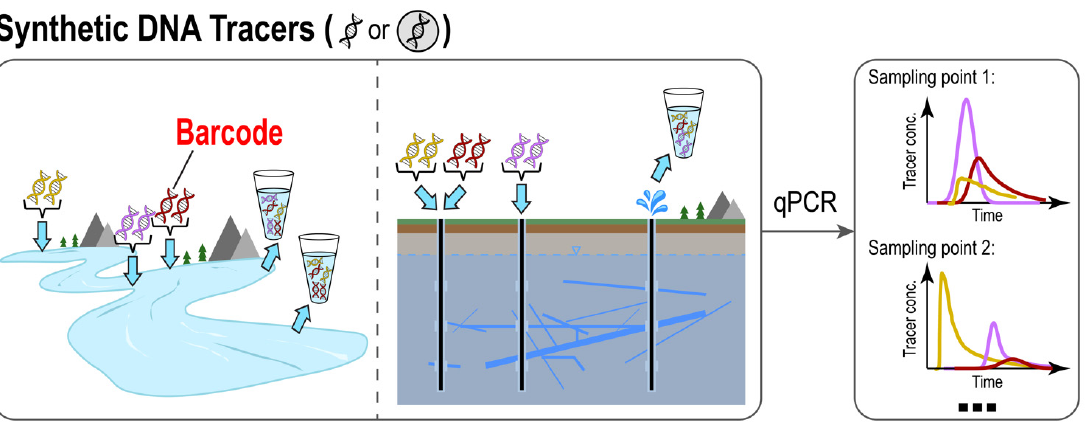
Figure 1. Schematic illustration of synthetic DNA-based tracer methods. The introduced DNA tracer can be either in its free from (naked DNA) or embedded into particle carriers (encapsulated DNA). Data are presented in the form of a breakthrough curve and interpreted in a similar manner to classic artificial tracer data.